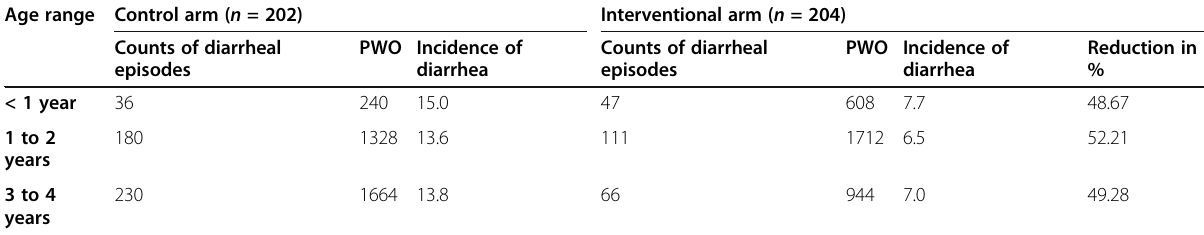
Incidence of diarrhea = counts of diarrheal episodes/100 person weeks of observation, PWO = person weeks of